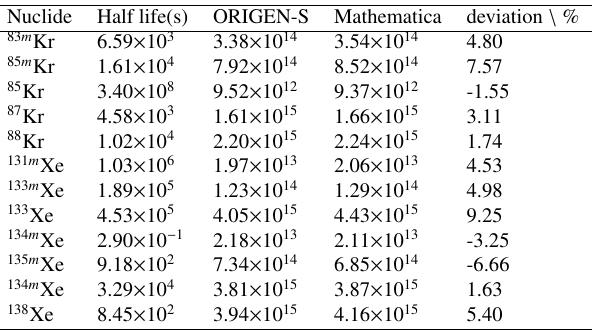
Figure 2. Reactor core model(Side view)